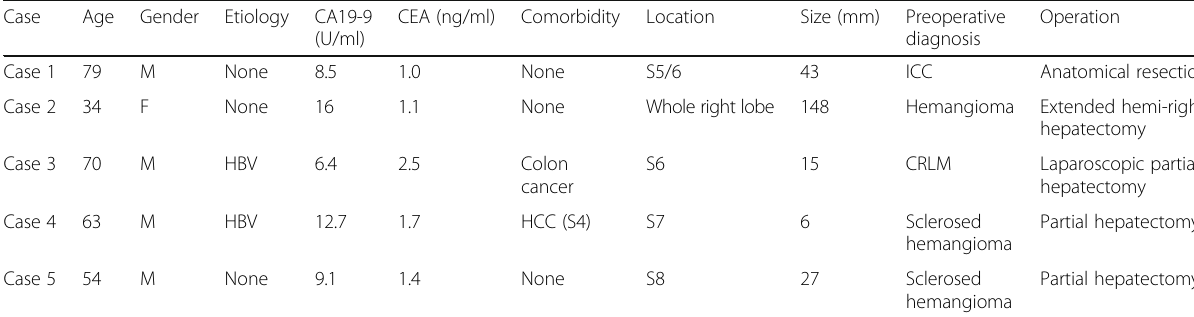
Table 1 Characteristics of five patients with hepatic sclerosed hemangioma